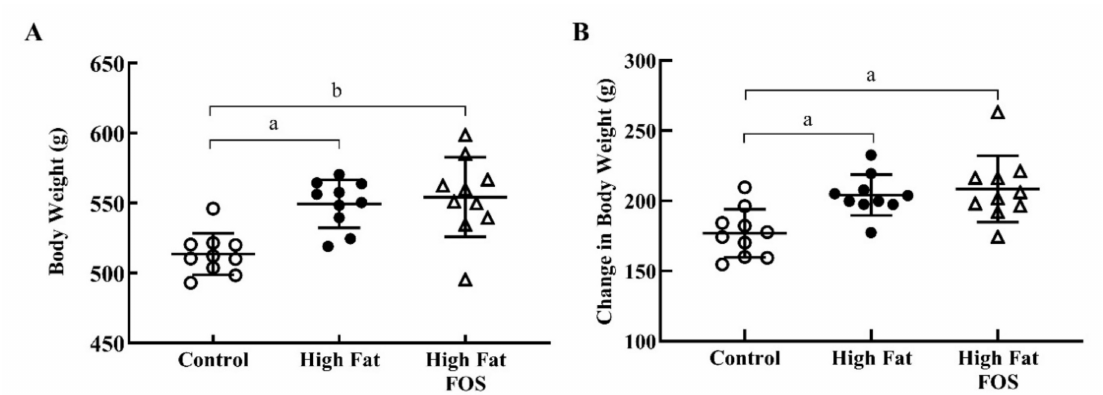
Figure 1. Body weights (mean ± standard deviation) for control, high-fat, and high fat- fructooligosaccharide (FOS) ( n = 10 each group). ( A ) Total body weight after 12 weeks on experimental diets. ( B ) Change in total body weight after 12 weeks on experimental diets. (a) Tukey-adjusted p -value < 0.01; (b) Tukey-adjusted p -value <